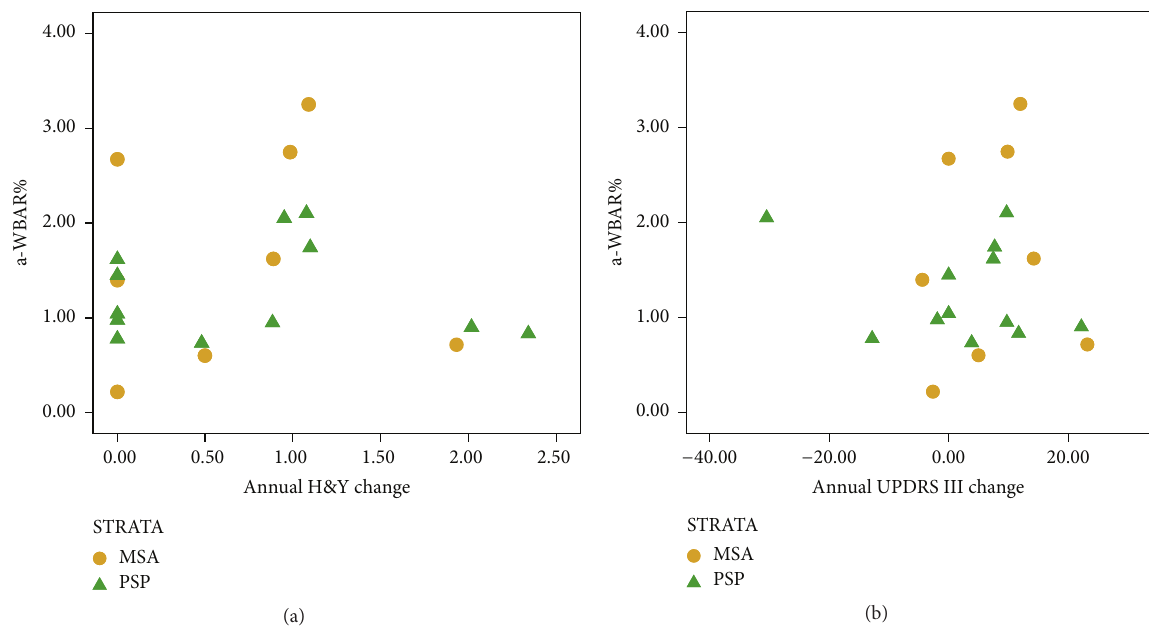
Figure 1: Relationships between annual changes in H&Y scale (a) and UPDRS (b) versus a-WBAR in MSA and PSP groups: 8 patients with brain atrophy showed either improvement ( < 0) or unchanged values (=0) on clinical measures.